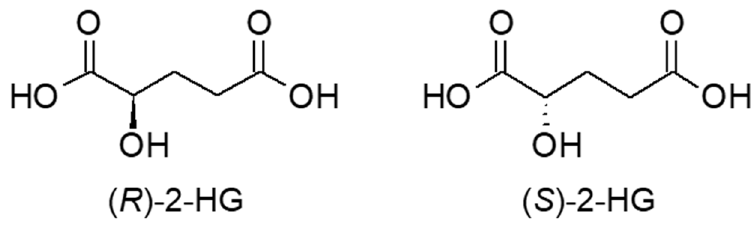
Figure 12. Chemical structures of ( R )- and ( S )-2-hydroxyglutaric acid (2-HG).